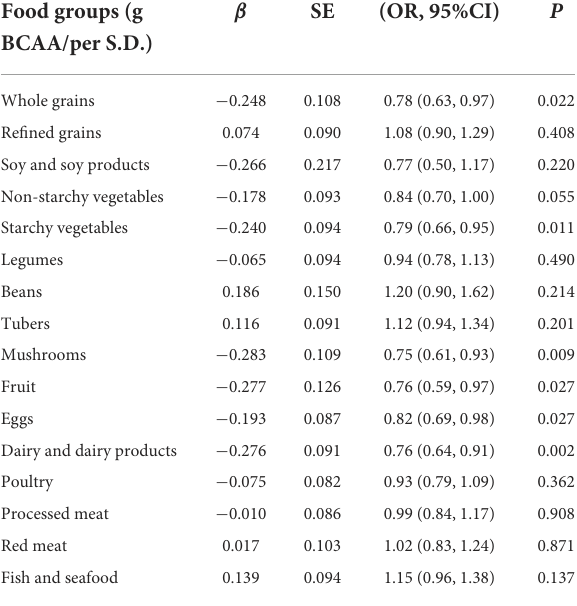
TABLE 7 Odd ratios and corresponding 95% confidence intervals with the fully adjustment model according to BCAA intake categorized by food groups and the risk of CVD in patients with type 2